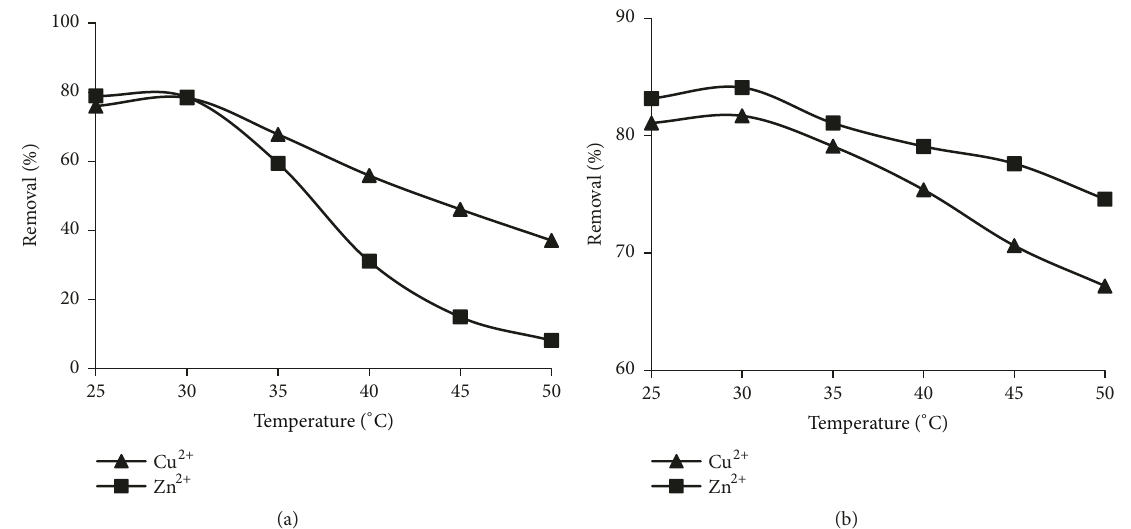
Figure 8: Effect of solution temperature on metal ion removal using (a) EC and (b) Fe 2 O 3